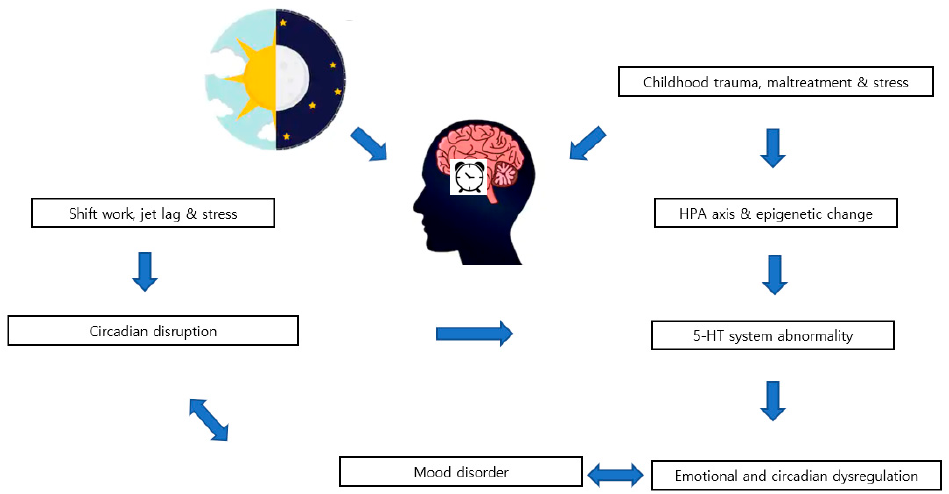
Figure 2. Schematic diagram indicating the relationship among the serotonergic system, circadian disruption, and mood disorder.